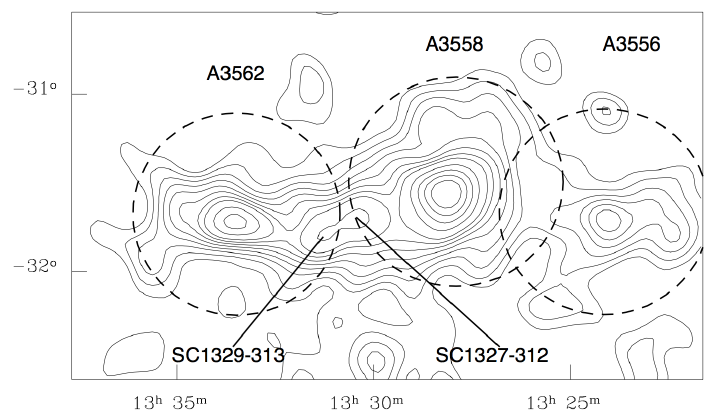
Figure 1. Distribution of the optical galaxies in the A3558 complex, shown as isodensity contours. The dashed circles represent the Abell radius for each cluster. The 325 MHz pointing is at the centre of A3558.